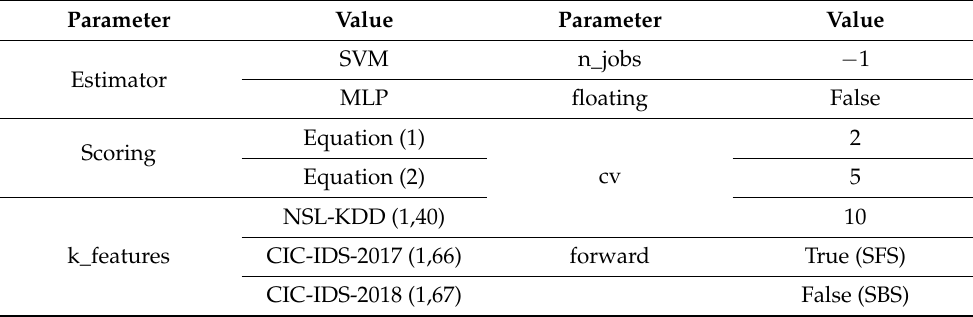
Table 4. Parameters of SFS and